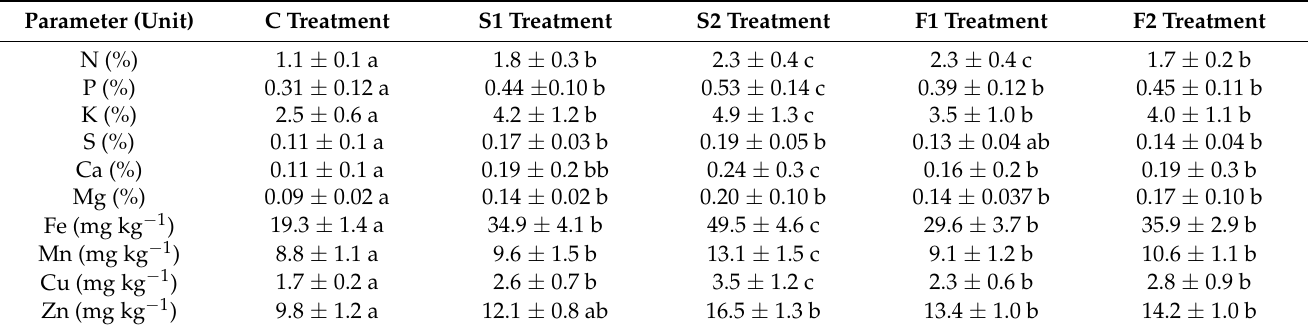
Table 5. Effect of biostimulant obtained from slaughterhouse sludge on chemical analysis (fresh wt.) in tomatoes harvested.